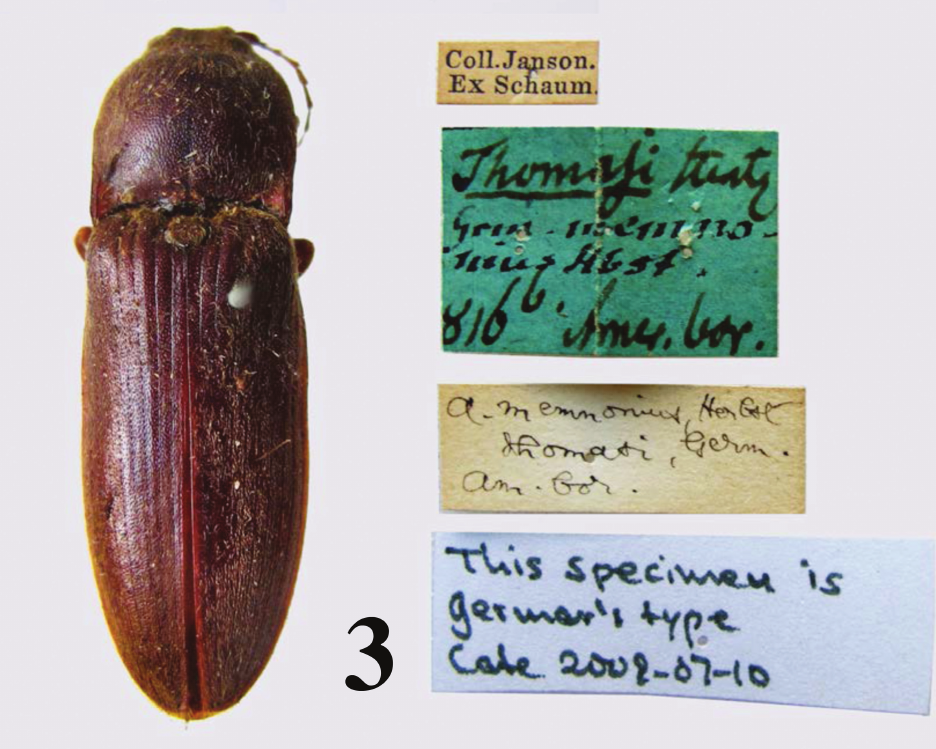
Fig. 2. Adult of Sharon amoenus (Philippi, 1861) comb. nov., ♂. Valdivia. Scale bar = 1 mm.